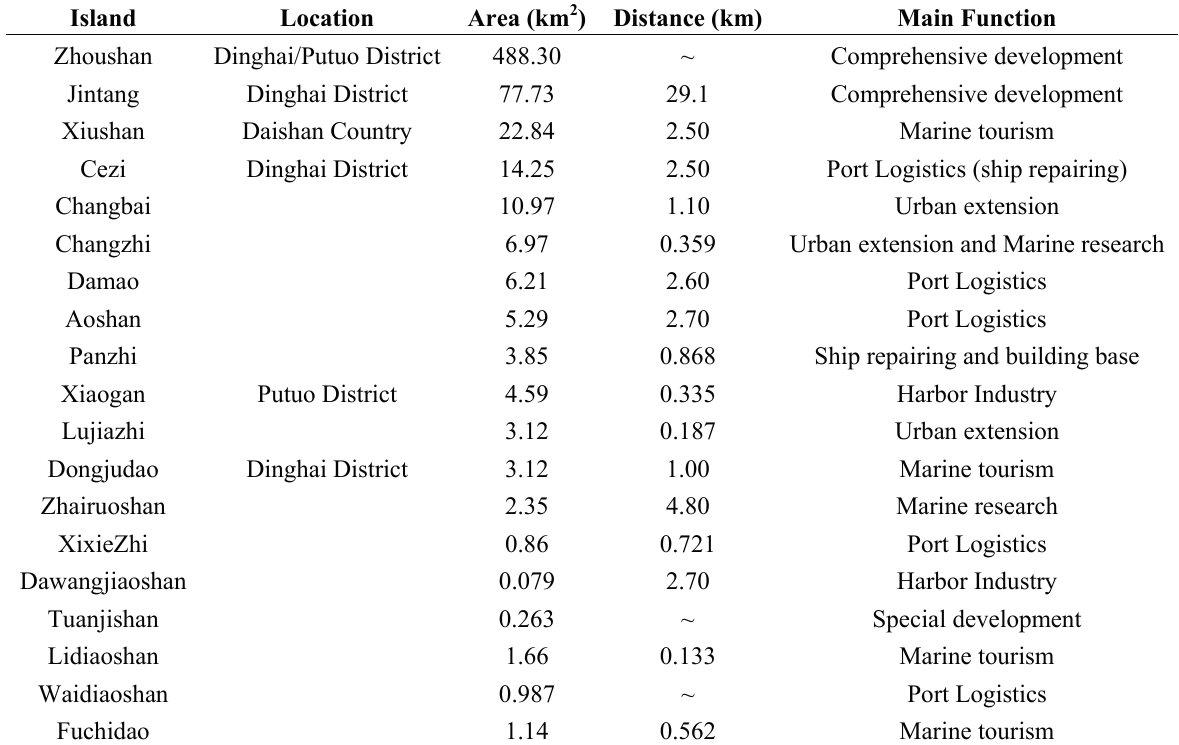
Table 1. Information on the main islands in the study area * .